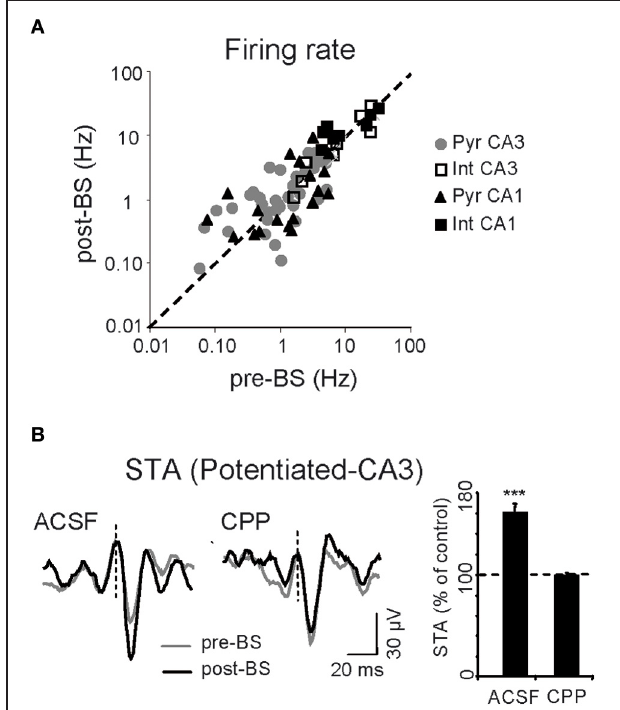
FIGURE 4 | Cell-specific effects of LTP. (A) Mean spontaneous firing rate of CA1 and CA3 cells before and after BS. Each symbol corresponds to a different neuron ( n = 6 animals). (B) Representative sample traces (left) and pooled results of all six experiments (right histogram) for CA3 spike-triggered averages (STA) of Schaffer LFPs before (gray) and after BS (black), following local administration of vehicle (ACSF) or CPP in the CA1 stratum radiatum. The histogram corresponds to the subgroup of CA3 pyramidal cells that showed STA potentiation. Vertical dashed lines indicate the spike time (zero) for LFP averaging ( ∗∗∗ p < 0 . 001, Student’s paired t